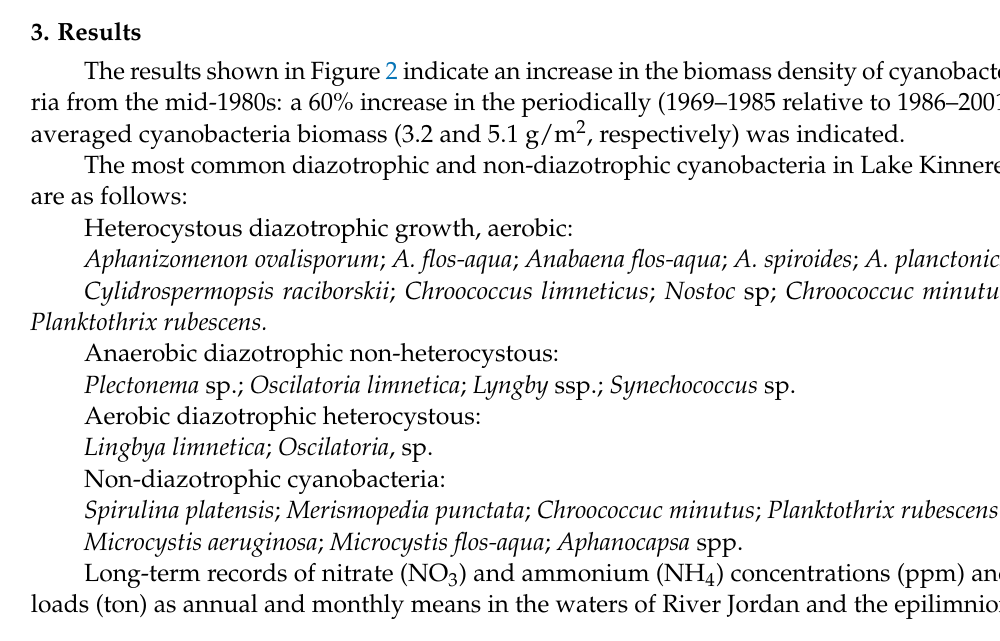
Figure 13. Linear prediction (95% CI) ( left ) and LOWESS smoother (0.8 bandwidth), trend of changes ( right ) between annual means of Peridinium wet biomass (g/m 2 ) and total nitrogen loads (ton) in the epilimnion of Lake Kinneret during 1970–2018. Figure 14. Linear prediction (95% CI) between winter and summer (January–June— Peridinium blooming season) of the means of Peridinium wet biomass (g/m 2 ) and total nitrogen loads (ton) in the epilimnion of Lake Kinneret during 1970–2018. The step forward in the data evaluation is presented in Figure 15.